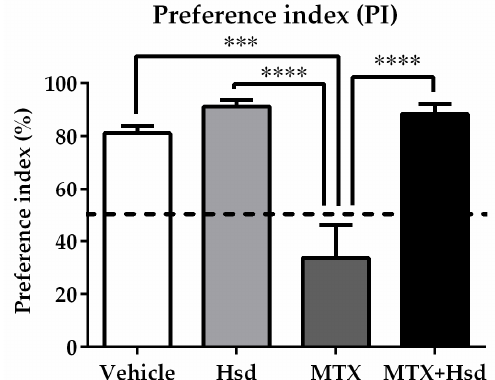
Figure 4. Significant differences among the four groups were found in terms of preference index (PI) in the NOR test. The PI measured in the MTX group differed significantly from those found the other three groups (*** p < 0.001, **** p < 0.0001). The PIs measured in the vehicle, Hsd, and MTX + Hsd groups were significantly higher than 50% chance (# p < 0.05), however that of the MTX group was lower than 50%. The dashed line indicates 50% chance.